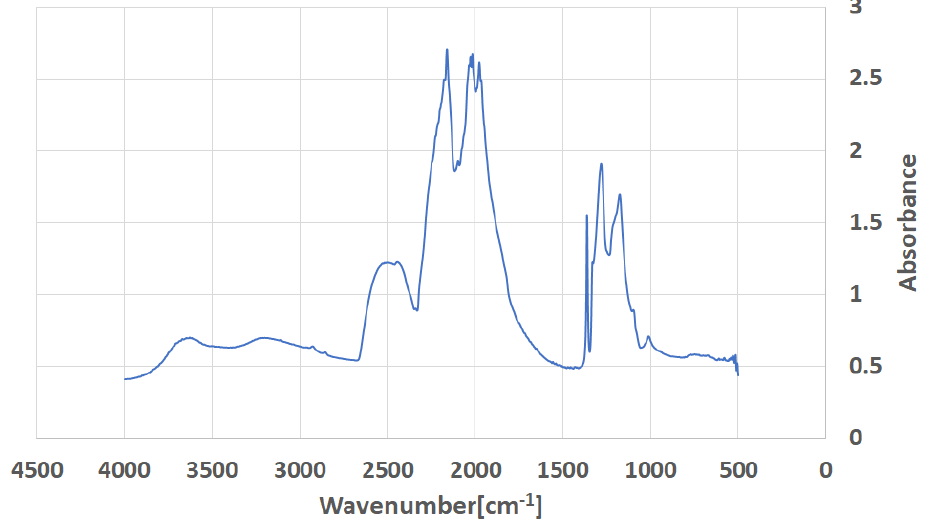
Figure 4. The infrared absorption spectra of the D master diamond. The absorption values at 1095 cm − 1 is 0.09.